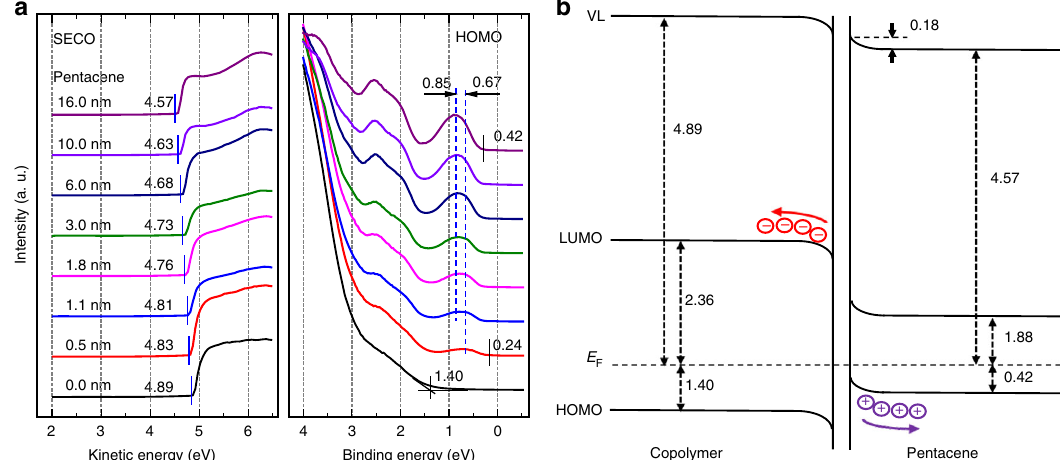
Fig. 5 Interface characterization. a UPS spectra of incremental pentacene fi lms on copolymer. b The derived energy-level diagram at the